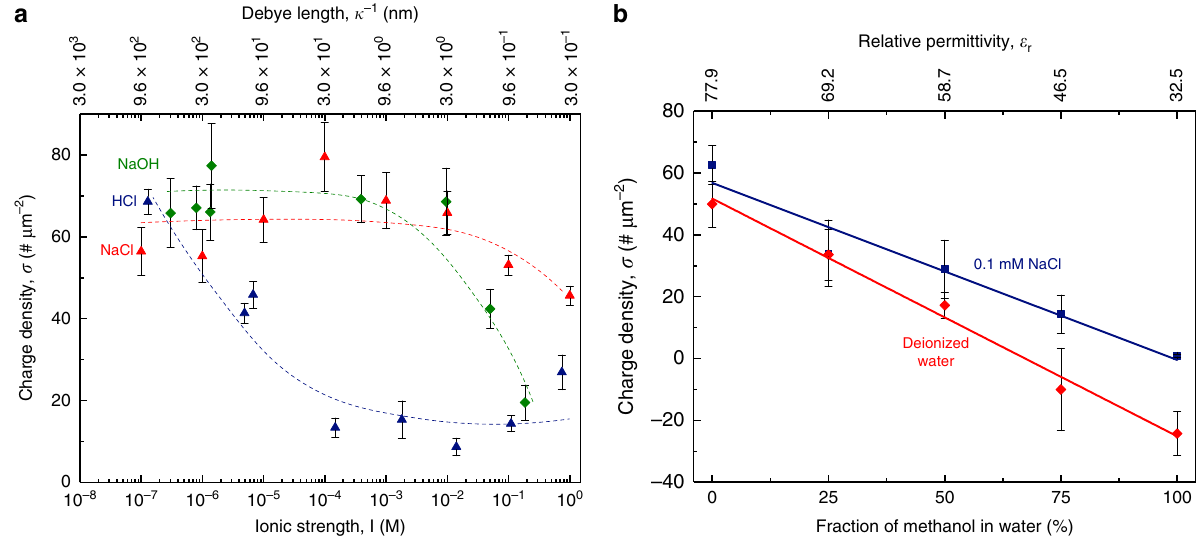
Fig. 5 Electri fi cation of water-hydrophobe interfaces as function of ionic strength, pH, and dielectric constant. a Effects of varying Debye lengths on electri fi cation at water-hydrophobe interfaces by varying ionic strengths with NaOH (green), HCl (blue), and NaCl (red). Aqueous electrolytes were drawn into polypropylene pipettes from charge-neutral reservoirs and dispensed into a Faraday cage connected to an electrometer to quantify electrical charges. The surface charge density was obtained by normalizing the observed charges by the solid-liquid interfacial areas inside the pipette prior to dispensing. (Dotted lines have been added to guide the eye.) b Effects of varying relative permittivity of liquids on the electri fi cation at water-hydrophobe interfaces by varying dielectric constants by adding methanol to water and aqueous NaCl solutions (0.1 mM), using the same technique as in a . Methanol-rich mixtures demonstrate lower electri fi cation in comparison to water-rich solutions (red datum points), and commensurate solutions with salty water (blue datum points). Error bars in each panel represent the standard deviation of ten